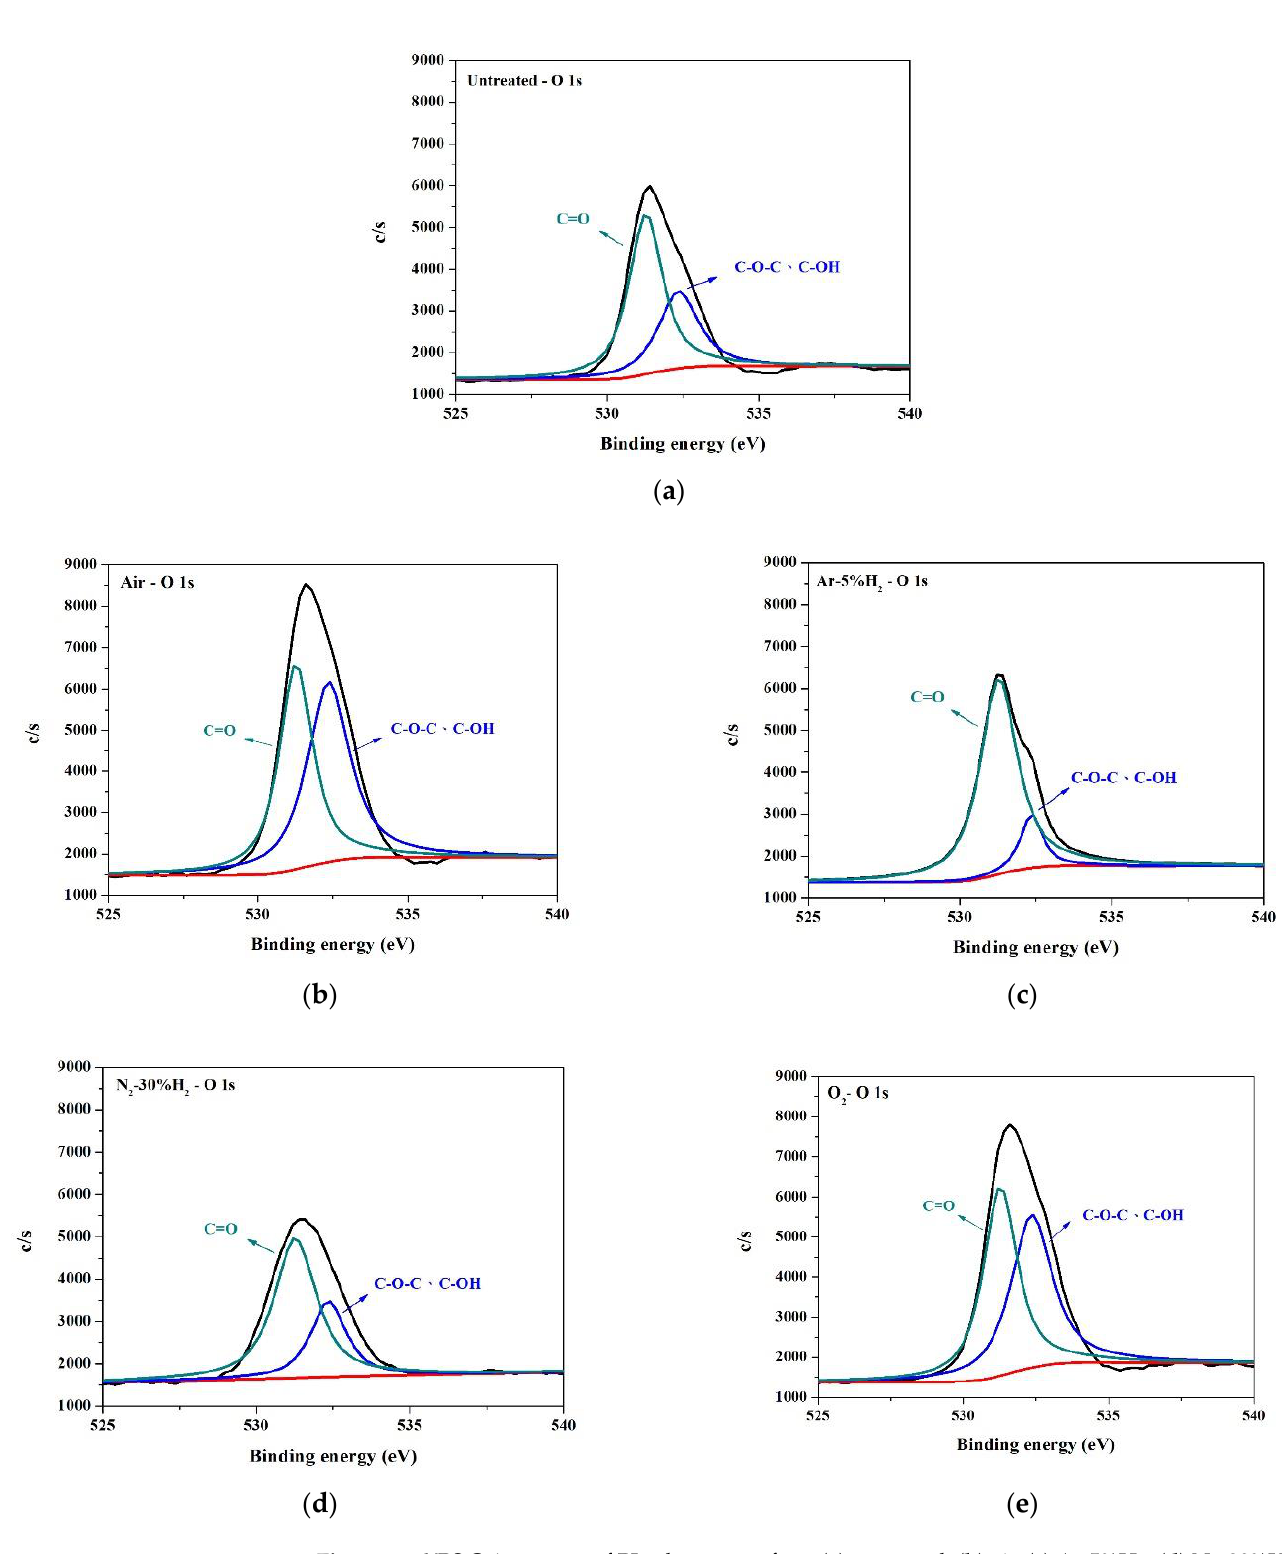
Figure 13. XPS O 1s spectra of PI substrate surface: ( a ) untreated, ( b ) air, ( c ) Ar-5%H 2 , ( d ) N 2 -30%H 2 , and ( e ) O 2 .